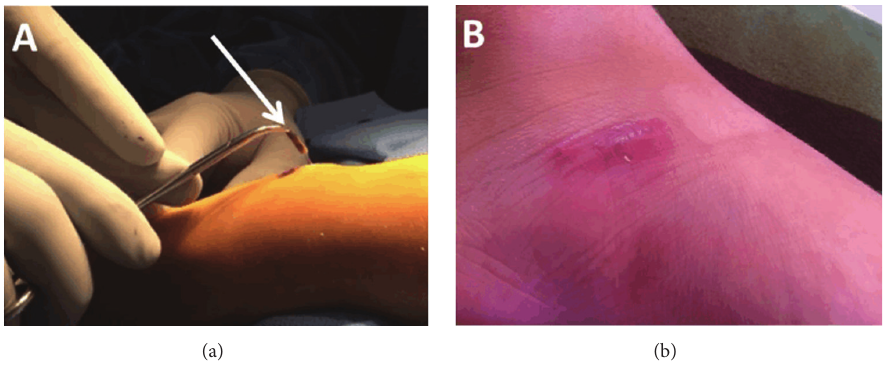
Figure 2: (a) Foreign body removal and (b) two-month